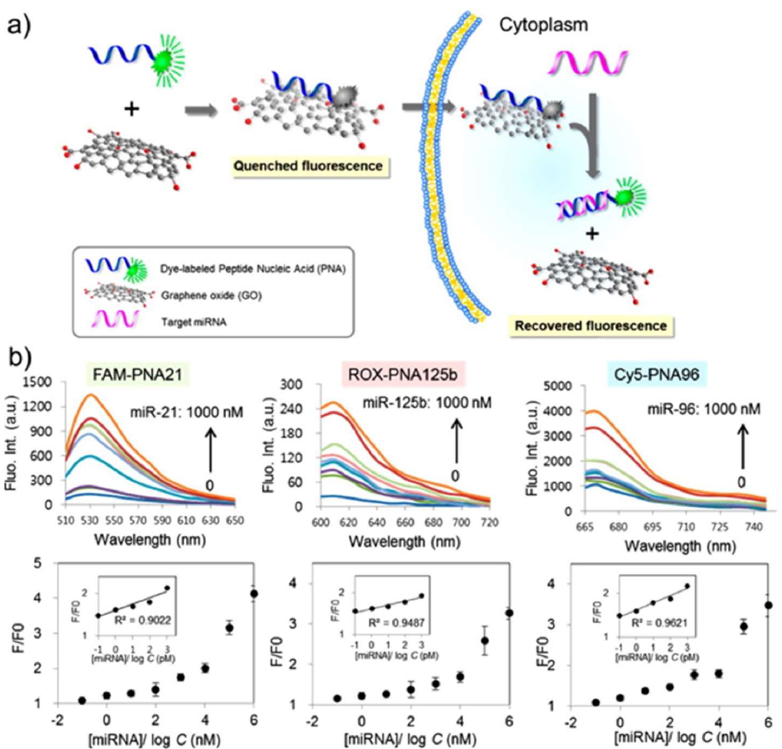
Figure 6. Scheme of strategy for an mRNA sensor based on NGO and PNA, and emission spectra and fluorescence images obtained for multiplexed mRNA sensing in vitro. ( a ) The fluorescence signal gets recovered when the fluorescent dye-labeled probes initially adsorbed onto the surface of NGO detach from NGO and hybridize with a target mRNA. ( b ) Three PNA probes: PNA21, PNA125b and PNA96 were designed for three different mRNA detections and prepared as conjugated with three different fluorescent dyes: FAM, ROX and Cy5. Reproduced from [117], with permission from American Chemical Society, 2013.